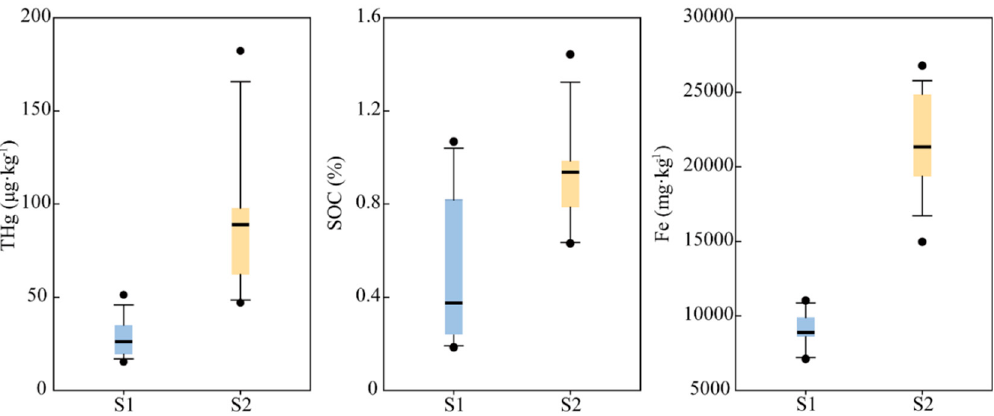
Figure 2. The contents of THg, SOC, and Fe in each profile (0–70 cm) (o represents an